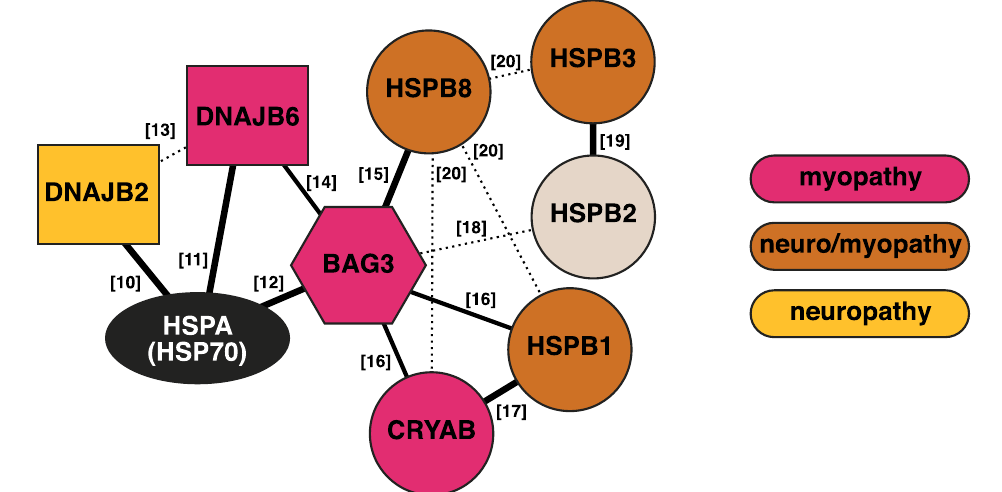
Figure 1. Interaction network of the discussed chaperones and cochaperones. Thick solid lines indicate interactions with established functional relevance. Dashed lines show detected interactions of unknown significance. The numbers indicate references [10–20]. Table 1. Chaperone and cochaperone genes currently known to underlie neuromuscular disorders.